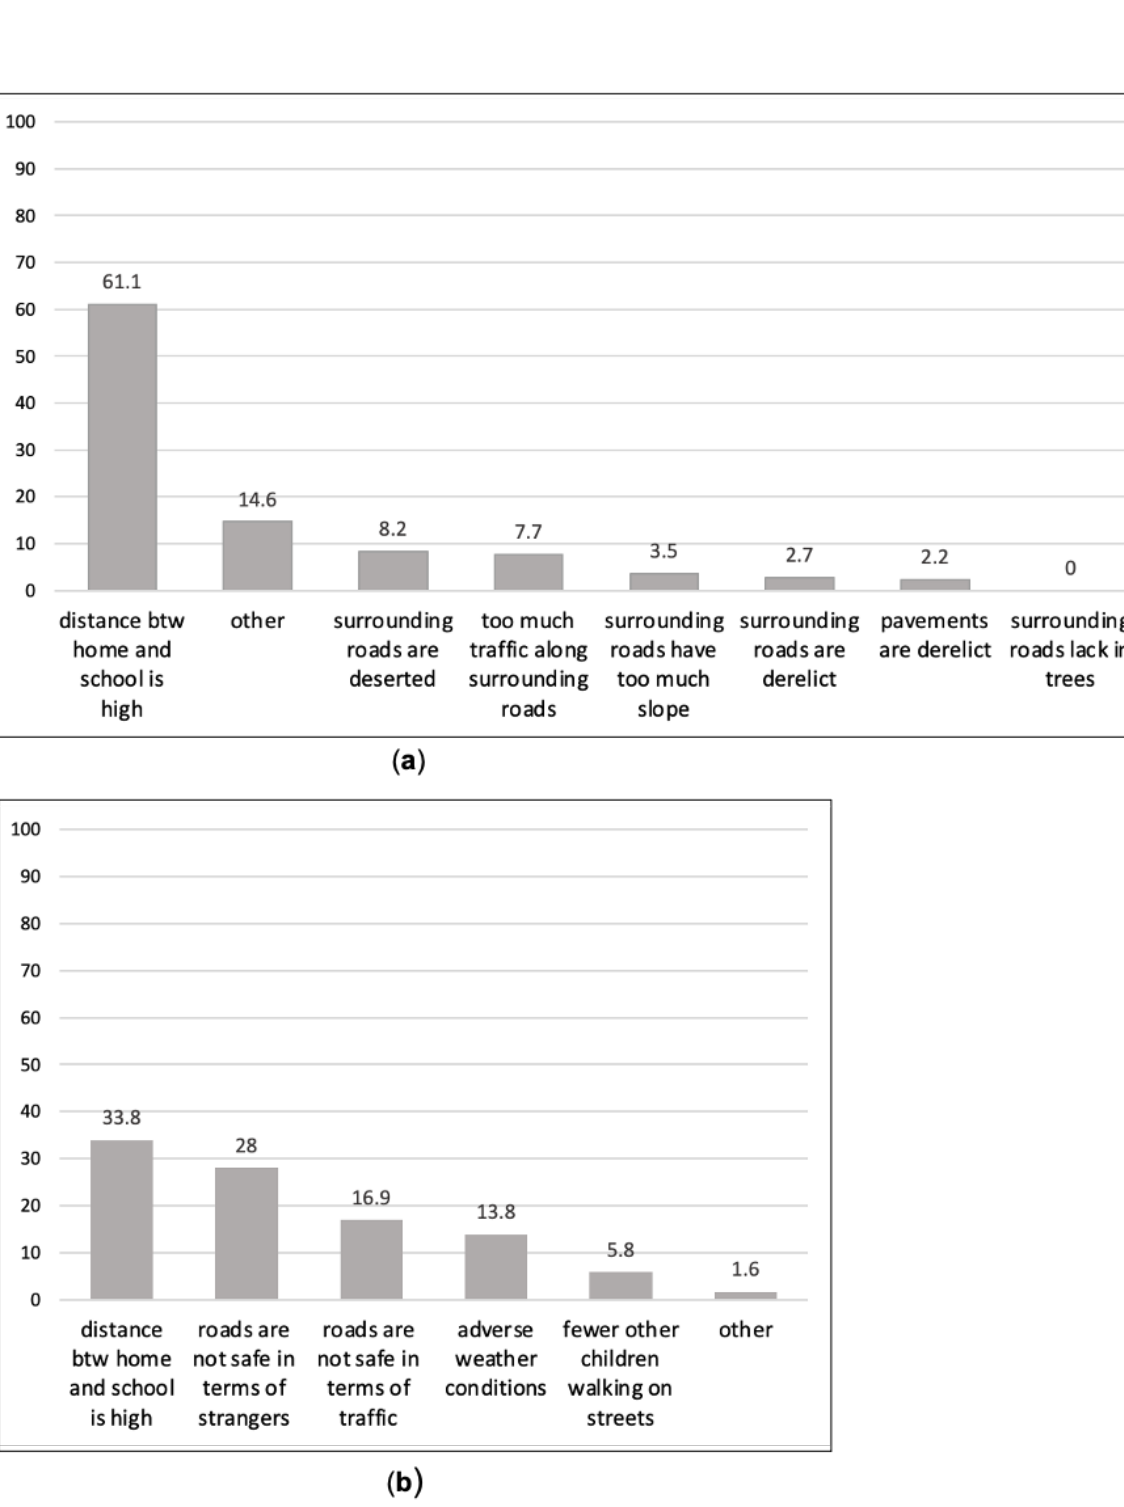
Figure 4. Responses of participants: ( a ) students’ primary reasons for not wanting to AST, and ( b ) parents’ reasons for not allowing AST.